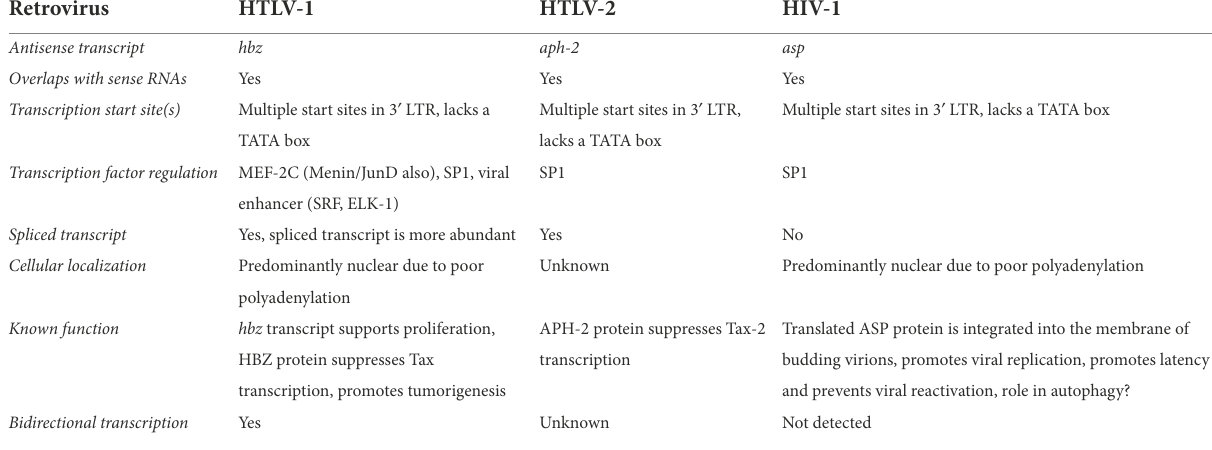
TABLE 1 Human retroviral antisense